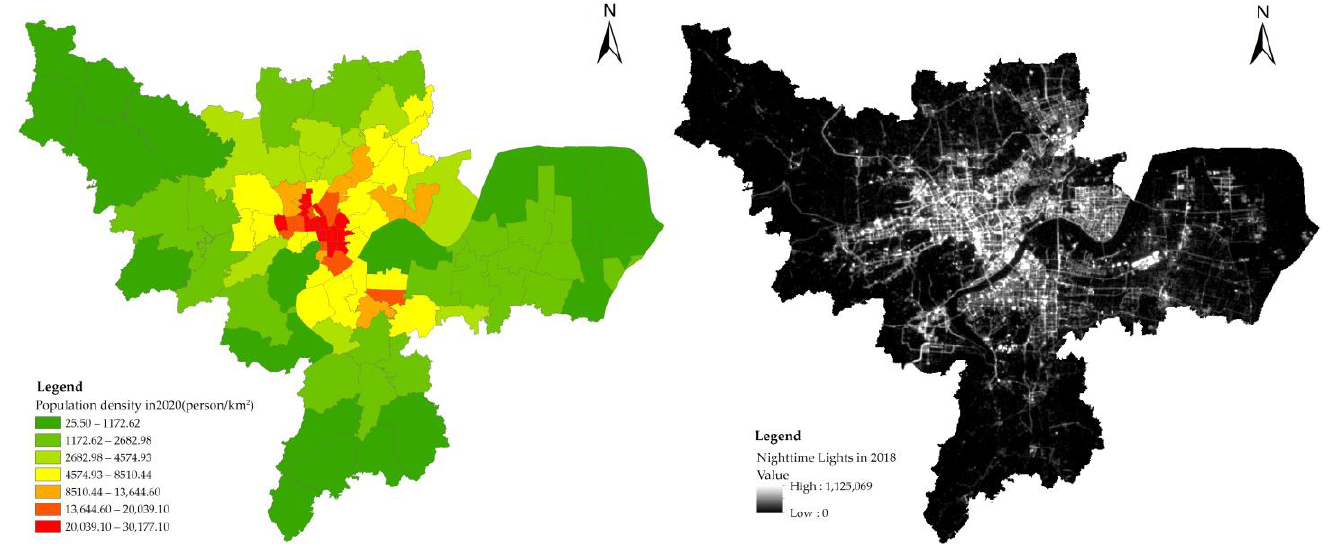
Figure 4. Spatial distribution of the population density and the nighttime lights in Hangzhou.